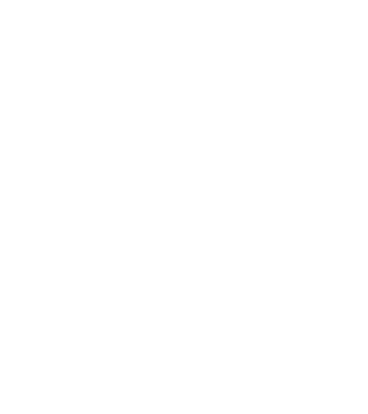
(cid:1) 2 at 7y and/or 11y (Table 1). Mean BMI increased throughout adulthood from 23.1 to 28.1kg/m 2 in males and 22.1 to 26.8kg/m 2 in females, ages 23 to 50y. Prevalence of obesity was < 2.5% in childhood, but was much greater, at ~25% in mid-adulthood, 45 to 50y (Table 1). Simple analyses of BMI at each age 7 to 50y showed a higher mean BMI in adulthood or OR for obesity in both sexes for neglect at 7/11y, physical and psychological abuse and, in females only, sexual abuse (Table 2). Pre-adolescent BMI, i.e. at 7 and 11y, was not elevated in association with abuse or neglect. Fig. 1 illustrates this pattern for physical abuse: e.g. for females, from no excess risk in childhood to an OR of 1.73 (1.28,2.32) at 50y. Thus for some maltreatments, simple analyses suggest a pattern from little difference to higher BMI with increasing age from child to mid-adulthood as seen in sensitivity analysis using (cid:1) 95 th BMI percentile for obesity (S1 Table).